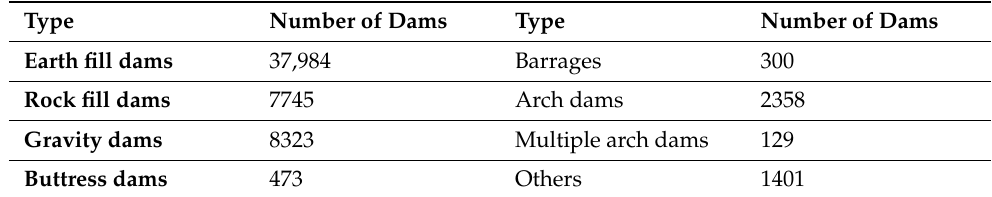
Table 2. Worldwide dam types and numbers (source: